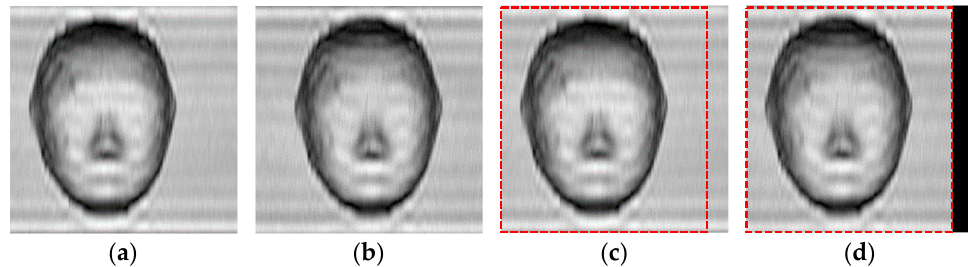
Figure 2. Modulation of high-resolution fringe pattern: ( a ) Modulation of 𝐼 (cid:2869) ′ ; ( b ) Modulation of 𝐼 (cid:3015) ′ ; ( c ) Modulation of 𝐼 (cid:2869) ′ with ROI; ( d ) Modulation of 𝐼 (cid:3015) ′ with ROI. ROI: region of interest.